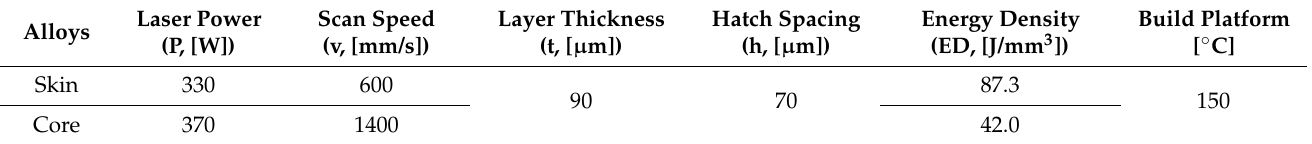
Table 2. Process parameters used to manufacture AlSi7Mg0.6 and AlSi10Mg0.3 bars and billets.